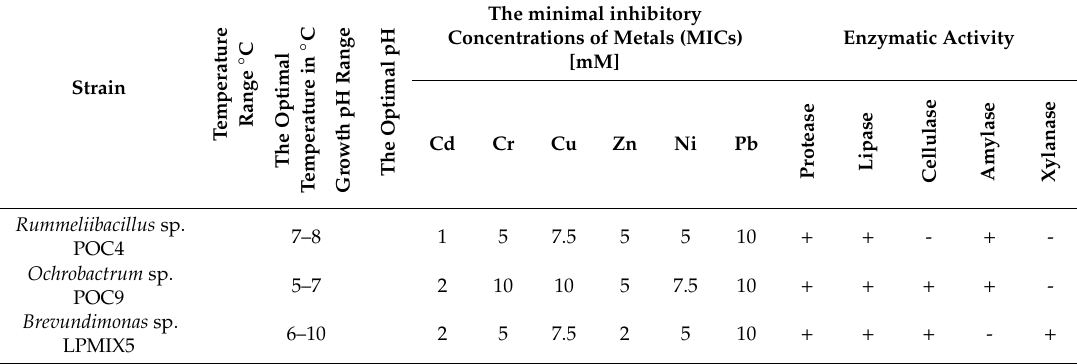
Table 1. Optimal culture conditions, minimal inhibitory concentrations of metals, and enzymatic activities determined for the analyzed